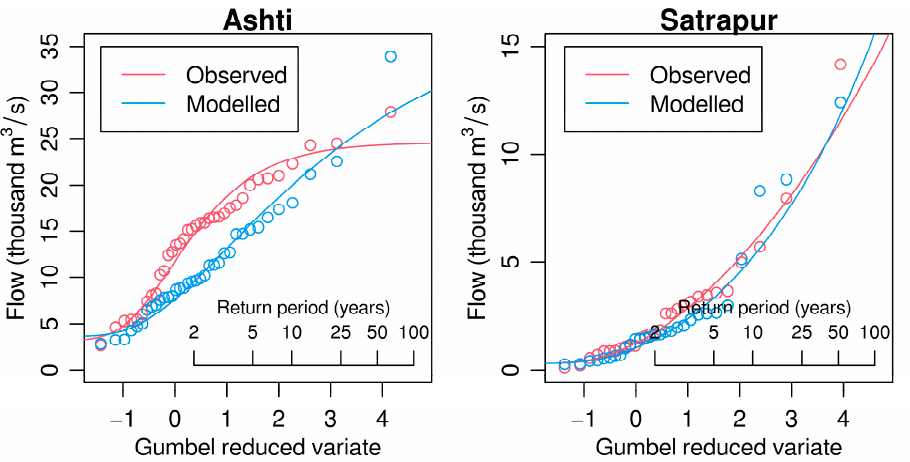
Figure 10. Observed and modeled flood frequency curves for Ashti and Satrapur (semi-lumped Figure 10. modeling).